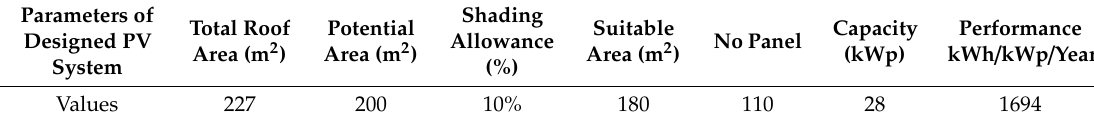
Table 3. Parameter of designed photovoltaic (PV) system (from GIS model).